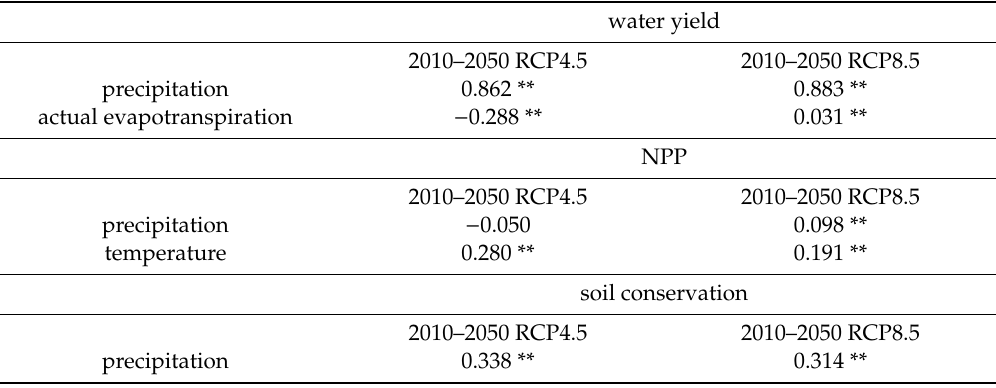
Table 5. Correlation between ecosystem services and impact factors for temporal